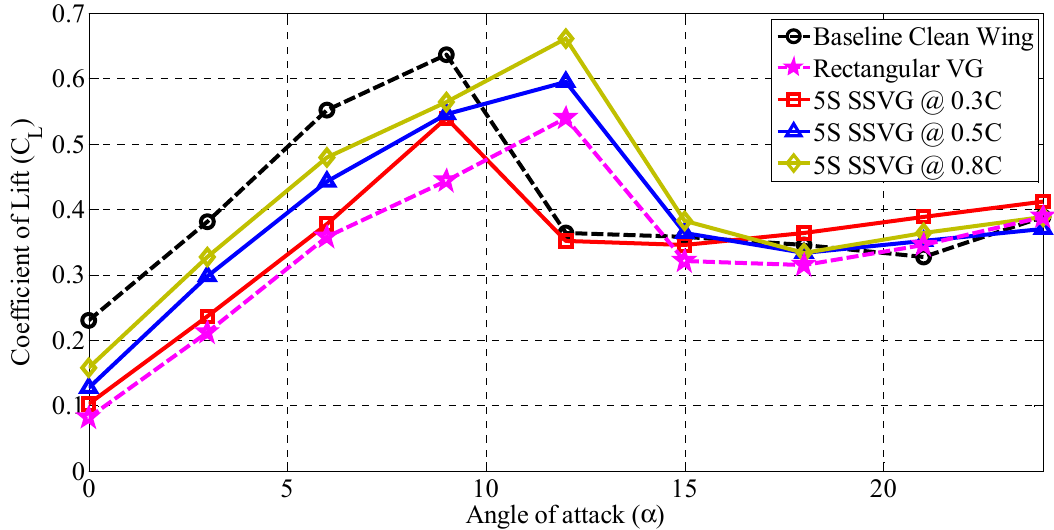
Figure 10. Coefficient of lift ( C L ) vs. angle of attack ( α ) for the baseline and modified model with Scheme (5S) SSVG. The drag coefficients ( C D ) of the baseline clean wing configuration, modified wing model blended with conventional rectangular VGs, and the modified models with 5S type SSVG fixed at various chordwise locations were compared against the angle of attack ( α ),